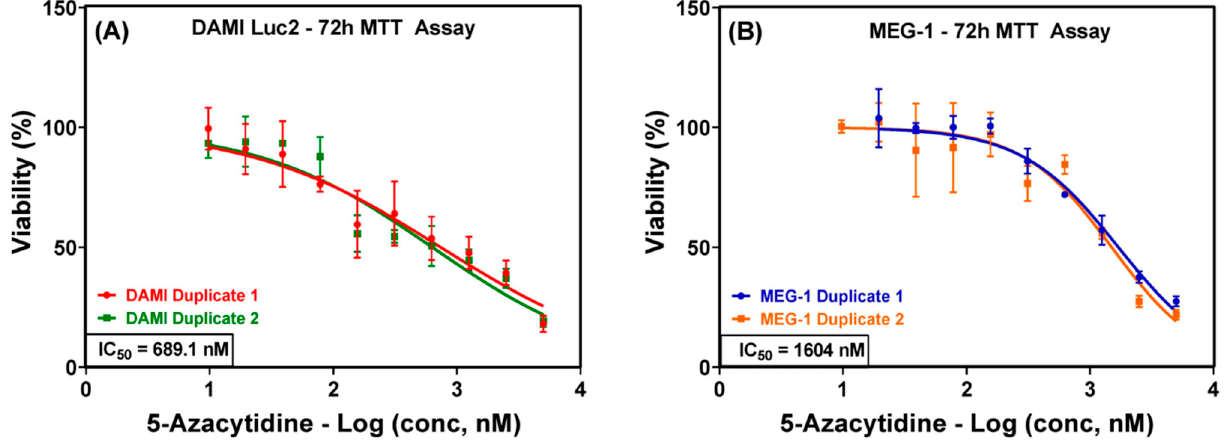
Figure 1. Viability rate and average IC 50 of DAMI Luc2 cells ( A ) and MEG-1 cells ( B ) treated with 5-azaC for 72 h.